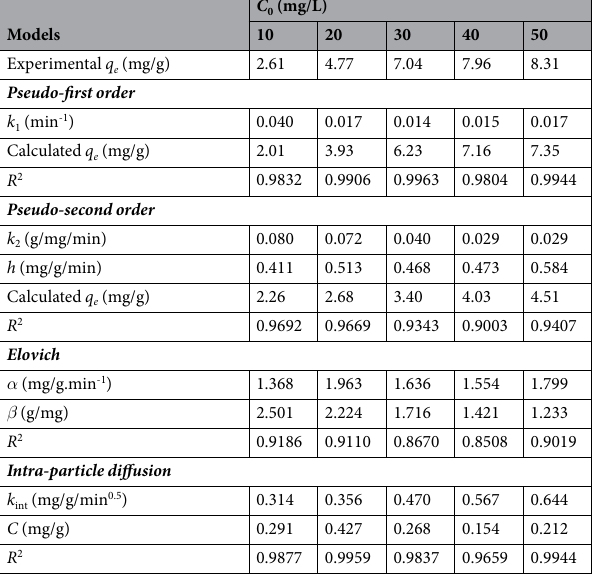
Table 2. Regression coefficients and kinetic parameters of pseudo-first order, pseudo-second order, Elovich and intra-particle diffusion